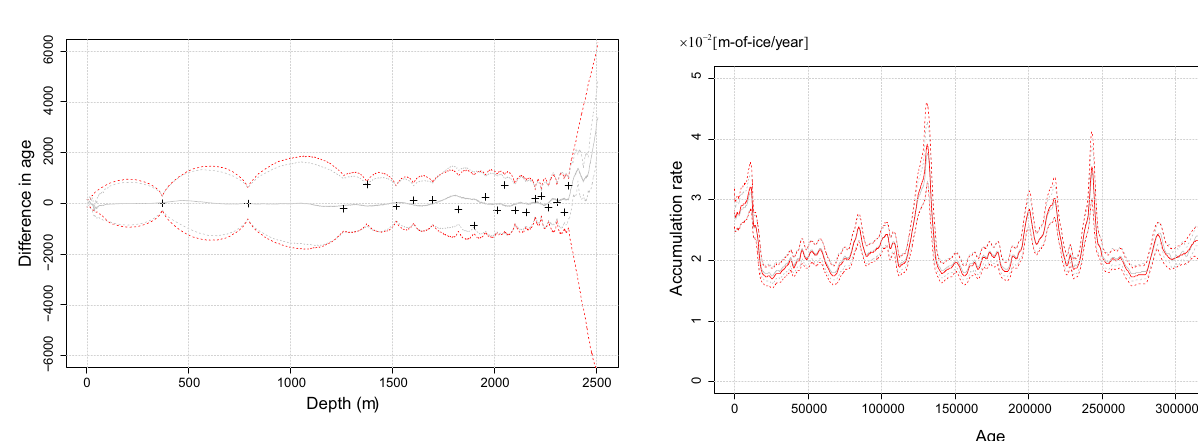
Figure 10. Difference of the 10th and 90th percentiles of the poste- rior distribution from the median of the posterior (red dotted lines) for the result without using the last five age markers. The difference of each tie point from the median of the posterior (black crosses) and the difference between the estimate with all the tie points and the estimate without using the last five tie points (grey line) are also shown.